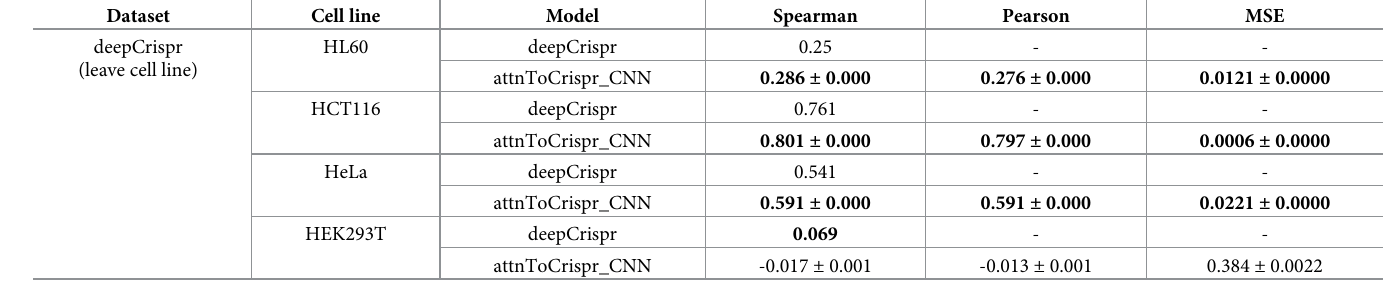
Table 3. Comparison of model performances on Crispr-Cas9 dataset. Model performance was evaluated with the leave-one cell line-out method. Spearman correlation, Pearson correlation, and MSE metrics are compared. Dataset